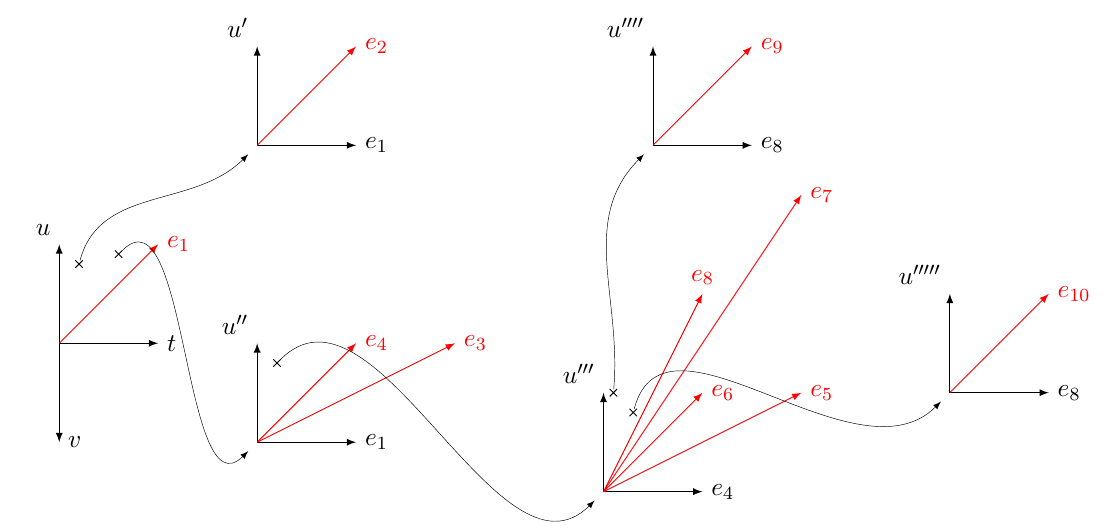
Figure 2. Schematic drawing of the toric resolutions of the II 9 (cid:0) 6 singularity, cf. section 4.4. The resolution starts on the left hand side with the base blow-up of u = t = 0. After this blow-up there are two non-minimal points in the u - e 1 -patch which are indicated by the two crosses. Both singularities lie along e 1 = 0 but u non-vanishing. Therefore, we have to do a coordinate rede(cid:12)nition such that the singularities lie at e 1 = u 0 = 0 and e 1 = u 00 = 0, respectively, to apply again our toric machinery. These cycles of toric resolution and searching for non-minimal points continue in the obvious way until all non-minimal singularities are